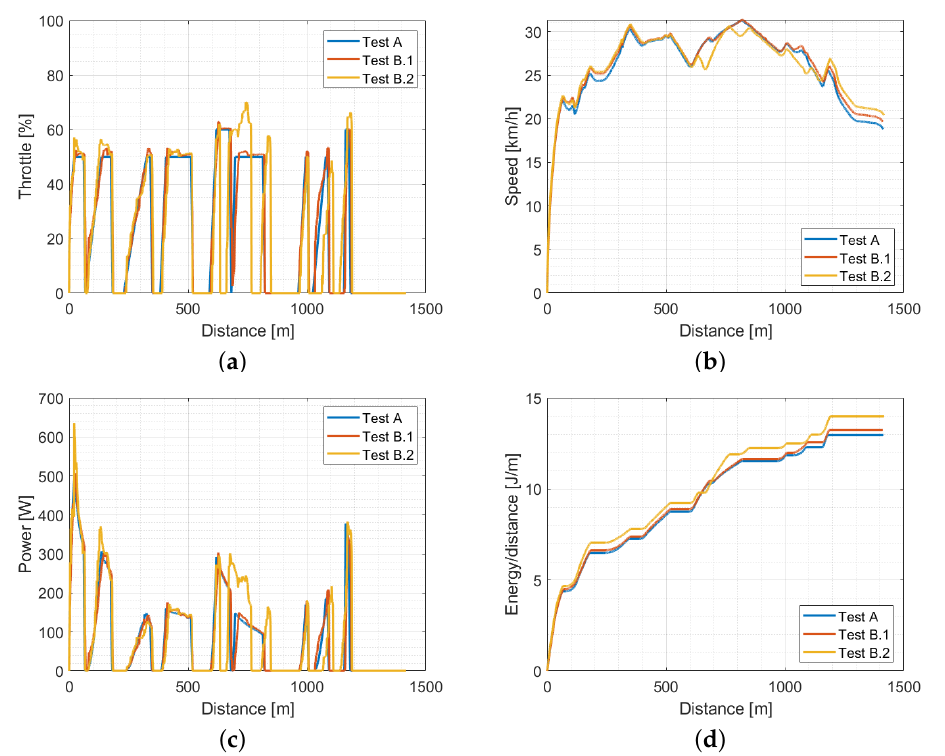
Figure 12. Comparison between Test A and Test B. ( a ) Input throttle. ( b ) Vehicle speed. ( c ) Electric power. ( d ) Energy consumption normalized over traveled